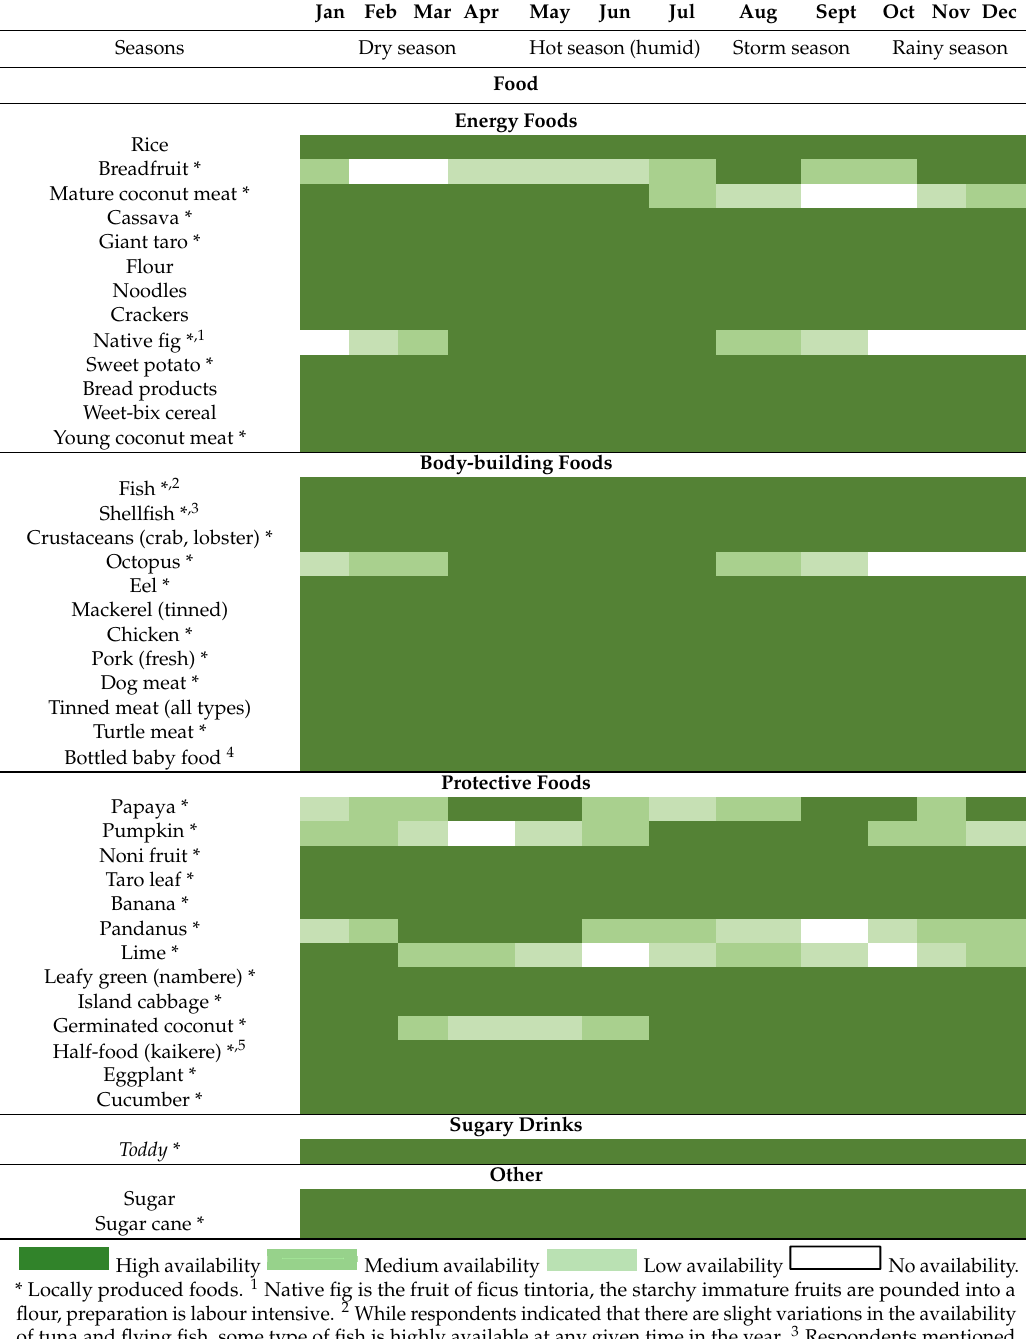
Table 4. Seasonal food availability calendar for Teaoraereke village in South Tarawa [urban].